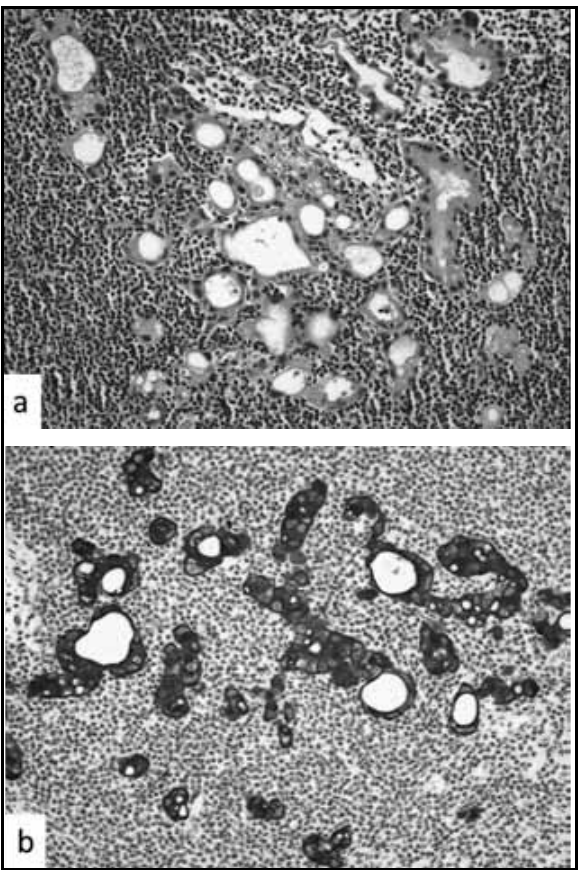
Figure – Sentinel lymph node with metastatic breast cells detected by a combination of H&E (a) and IHC (b)